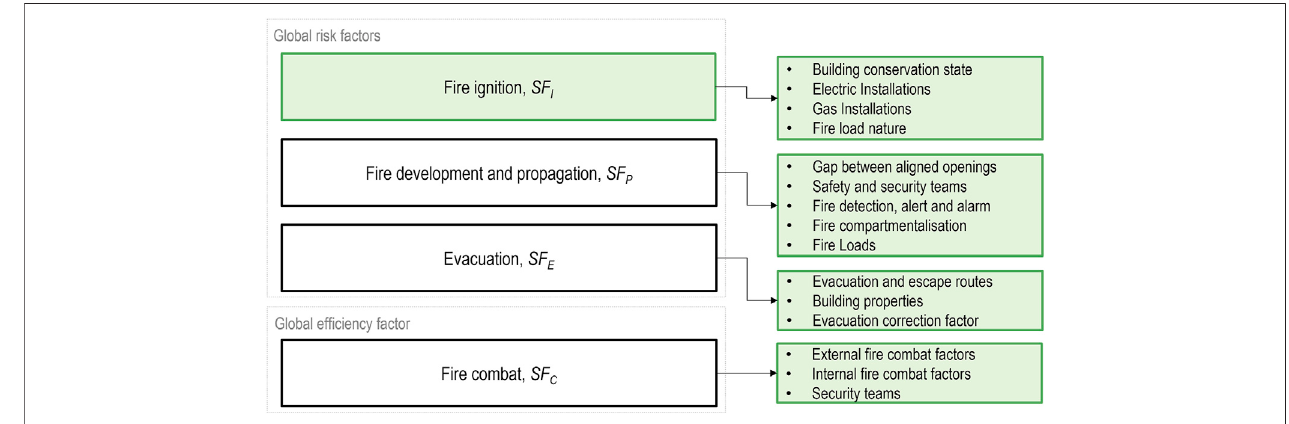
FIGURE 7 | Global Risk Factors and Global Ef fi ciency Factors and their corresponding partial factors. Adapted from (Granda and Ferreira, 2019).